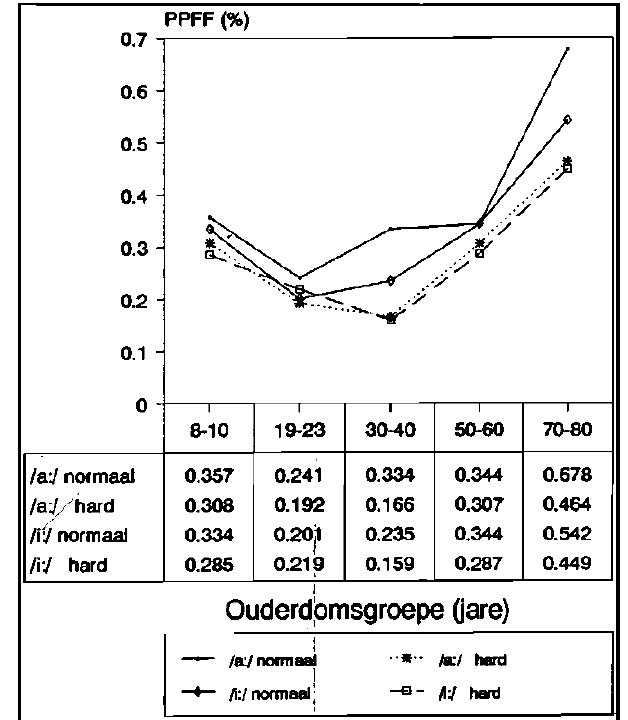
Figuur 3:PPFF-waardes van mans en dames in verskillende ouderdomsgroepe tydens produksie van /a:/ en /i:/ met normale en verhoogde luidheid. - Ouderdomsverwante verandering in PPFF Lae PPFF-waardes reflekteer relatief hoe stabiliteit in stembandvibrasie. Die groep 19-23 jaar verkry dan ook die laagste gemiddelde PPFF-waarde vir /a:/ en /i:/, wat dui op die mees stabiele stembandvibrasie van al die ouderdomsgroepe. Orlikoff (1990a) rapporteer dat liggaamsfunksionering maksimum effektiwiteit tussen 20-29 jarige ouderdom bereik. Die lae PPFF-waardes